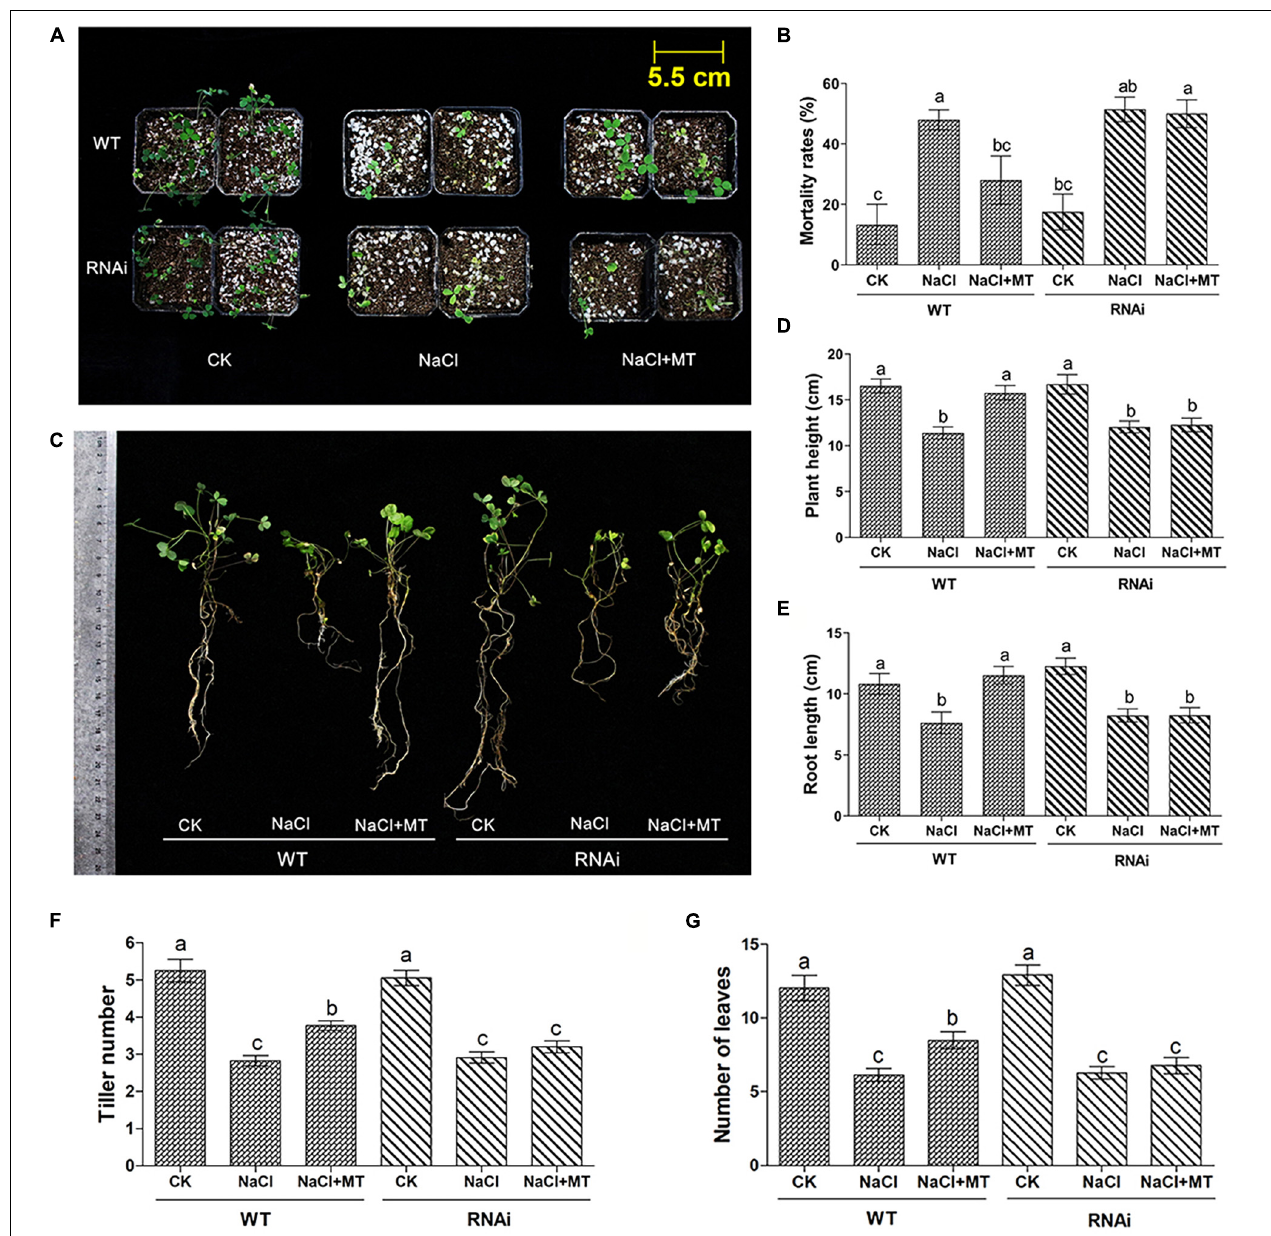
FIGURE 7 | The phenotype of alfalfa seedlings under salt stress and MT treatment upon MsPMTR1 gene knockdown. (A) The phenotype of a representative individual from each treatment. (B) Mortality rates, n = 24. (C) The Phenotype of representative seedling from each treatment. (D) Plant height, n = 30. (E) Root length, n = 30. (F) Tiller number per seedling, n = 35. (G) The Number of leaves per seedling, n = 35. Error bars show the SE between biological replicates and a t -test was performed between different treatment groups. Different numbers indicate significant differences ( p (cid:53) 0.05) between different treatments. WT, control pKGWRR-RFP transformed seedling. RNAi, MsPMTR1 -silenced seedling. CK, control water treatment. NaCl, 137 mM NaCl. NaCl + MT, 137 mM NaCl + 150 µ M